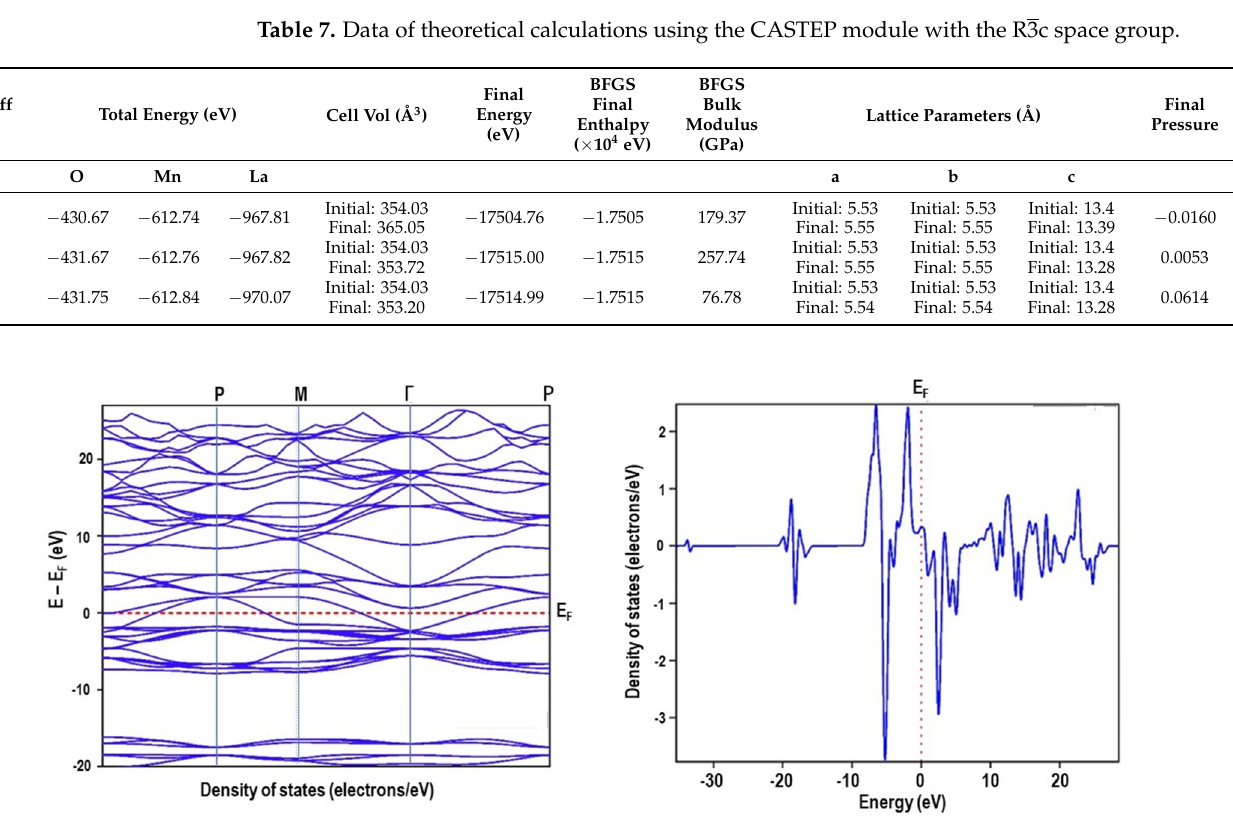
Figure 9. CASTEP GGA–PBE band structure and DOS of cubic perovskite LaMnO 3 .